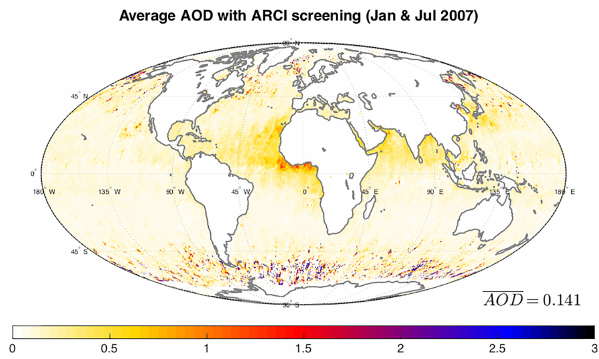
Figure 5. Average AOD distribution with ARCI ≥ 0 . 15 screening for the combination of January and July 2007. The data are mapped to a 0 . 5 ◦ × 0 . 5 ◦ grid. There is substantial improvement in the global distribution of mean AODs when compared to the unscreened data in Fig. 2. However, some residual high AOD values remain over re- mote oceans. They can be further screened using other approaches.